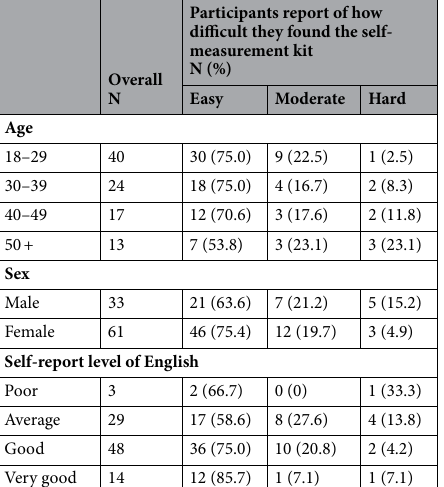
Concordance correlation coefficient